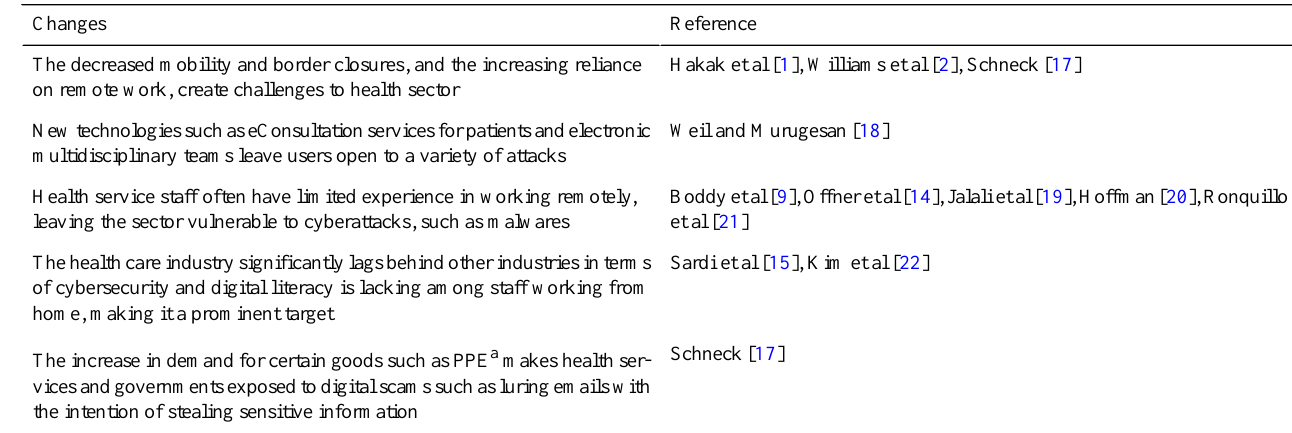
Table 1. Health sector condition changes due to COVID-19. ReferenceChanges